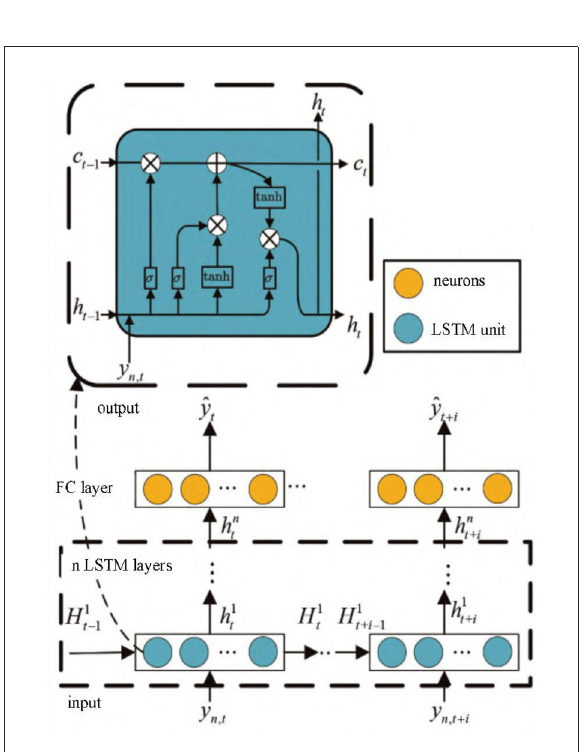
FIGURE4 Waveform prediction model based on